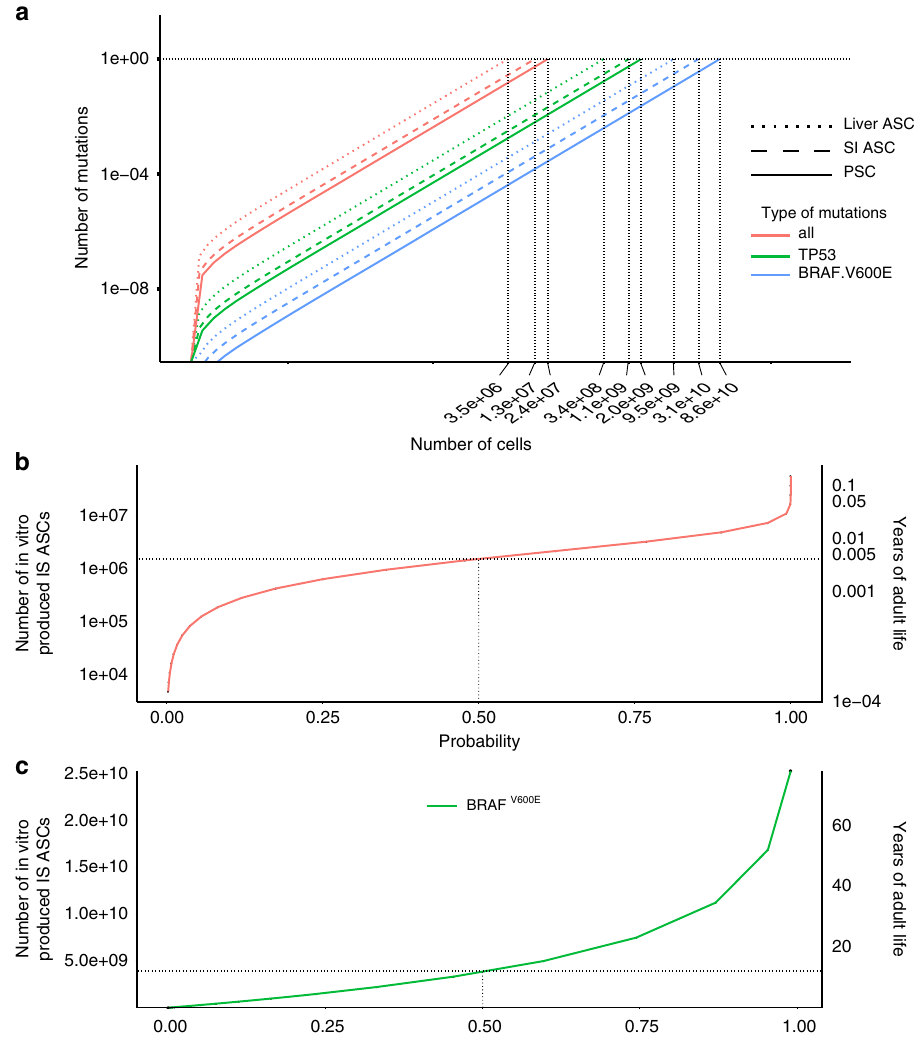
Fig. 4 Modeling the oncogenic mutations in in vitro-cultured stem cells. a The number of oncogenic mutations as a function of the number of in vitro- produced cells. b The probability of oncogenic mutations ( x -axis) as a function of the number of in vitro-produced ASCs (primary y -axis,) and as a function of years of adult life (secondary y -axis). c The probability of BRAF V600E mutations ( x -axis) as a function of the number of in vitro-produced ASCs (primary y -axis), and as a function of years of adult life (secondary y